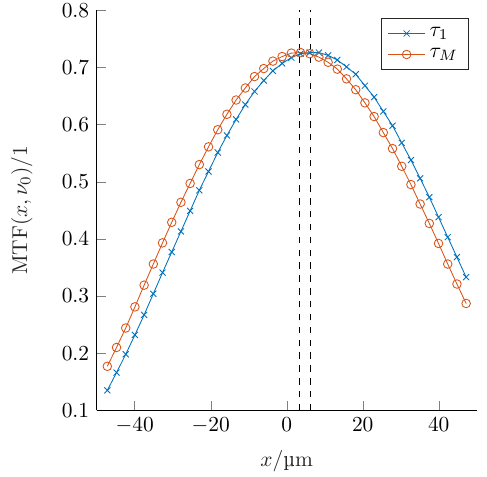
Figure 2. Comparison of the recorded MTF through focus curves evaluated at the spatial freuqency ν 0 = 100lp / mm at temperature τ 1 = 39 . 55 ◦ C at time t 1 ≈ 3min (blue crosses) and the stationary camera temperature τ M = 48 . 44 ◦ C at time t M = 193min (red circles). The black dashed lines indicate the position of the max- imum of the MTF through focus curves, which coincide with the focus position P f 1 , P fM respectively.